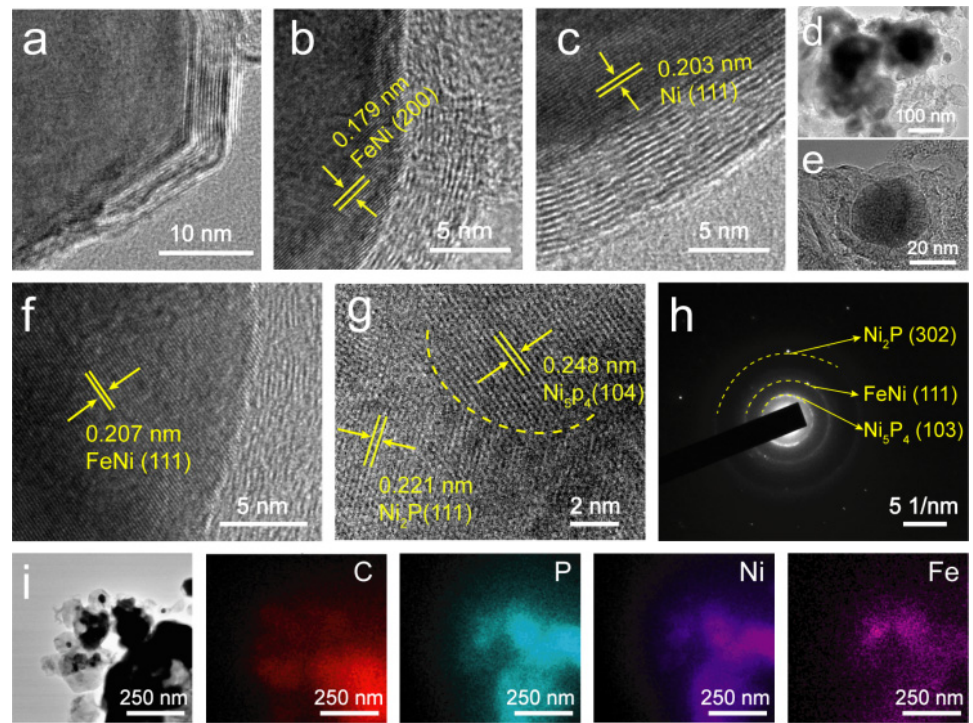
Figure 4. ( a ) TEM and ( b , c ) HRTEM images of Ni–FeNi@C. ( d ) TEM and ( e – g ) HRTEM images of Ni 5 P 4 /Ni 2 P–FeNi@C. ( h ) SAED and ( i ) STEM images and corresponding elemental mapping images of C, Ni, Fe and P for the Ni 5 P 4 /Ni 2 P–FeNi@C sample.